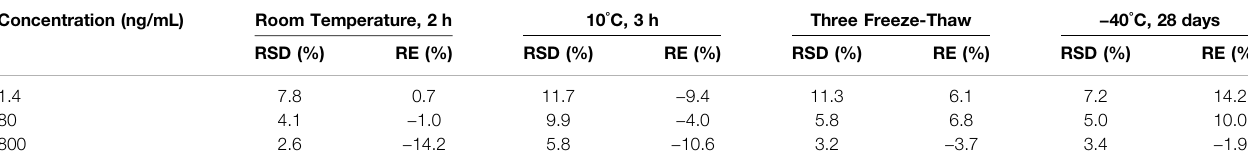
RSD, relative standard deviation; RE, relative error.